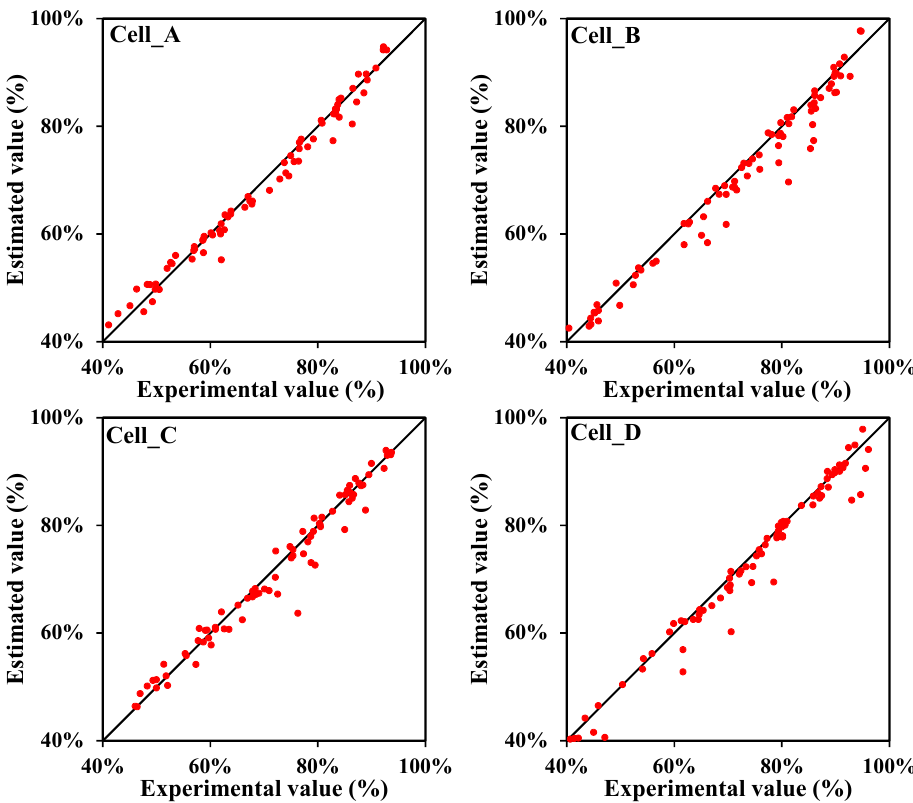
Figure 8. SOC estimations (dots) and deviations from correct values (diagonals) from random samplings of cells A – D using cell A for model construction.